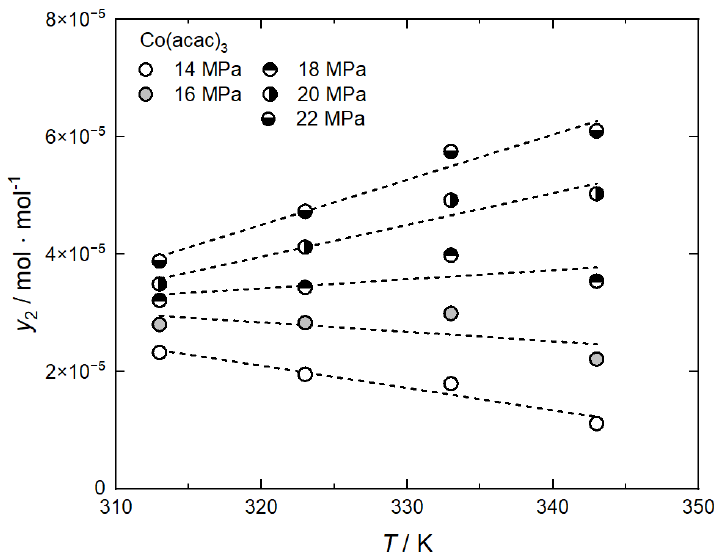
Figure 4. Solubility behavior of Co(acac) 3 in scCO 2 ; experimental data taken from [21]; the dashed lines are a guide for the eye.